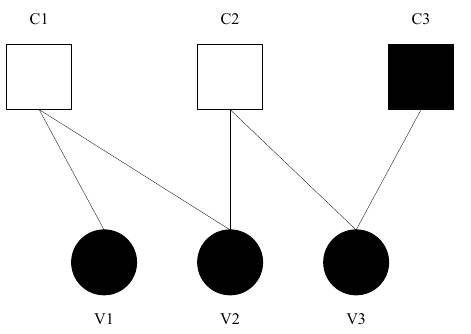
Figure 2. A (3,1) trapping